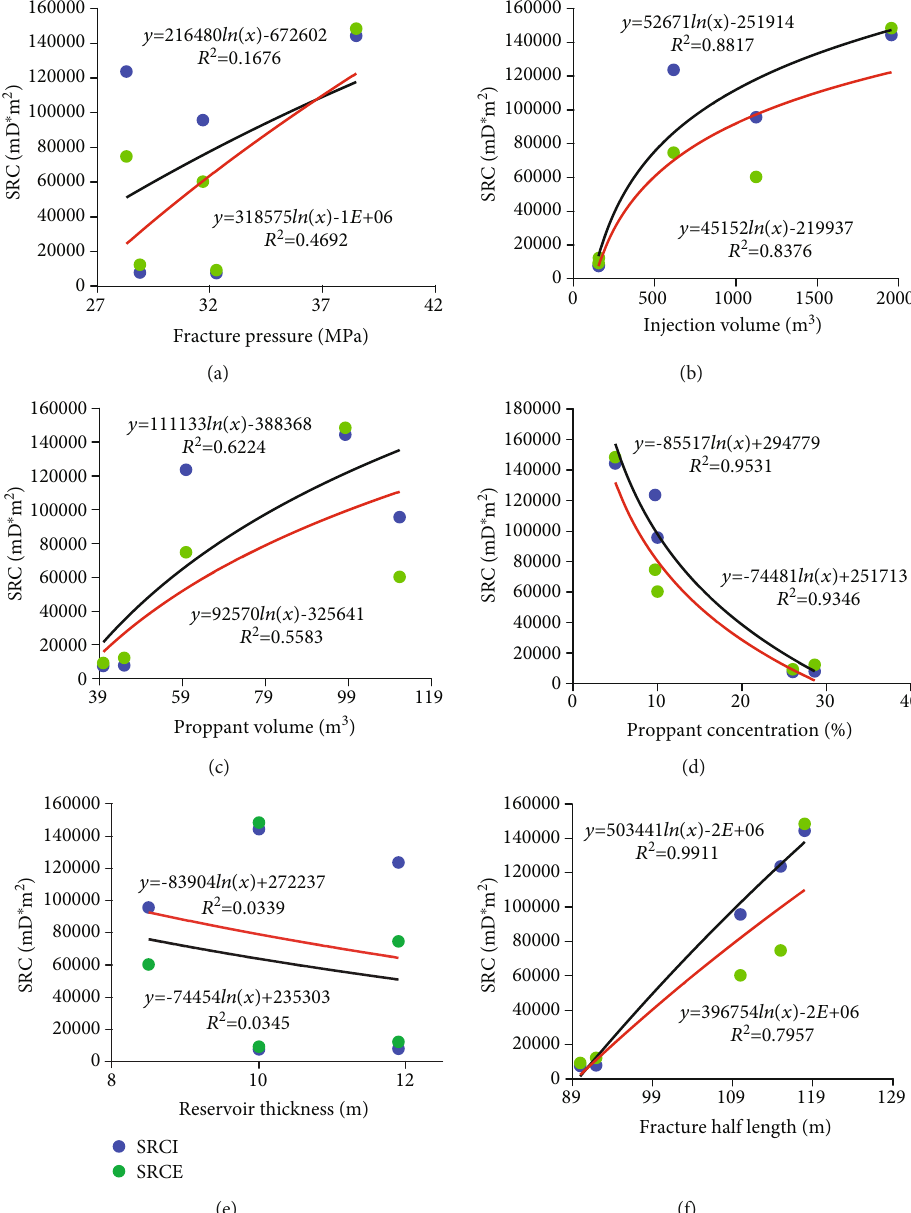
Figure 8: Analysis of the in fl uence factors of the fi rst stage